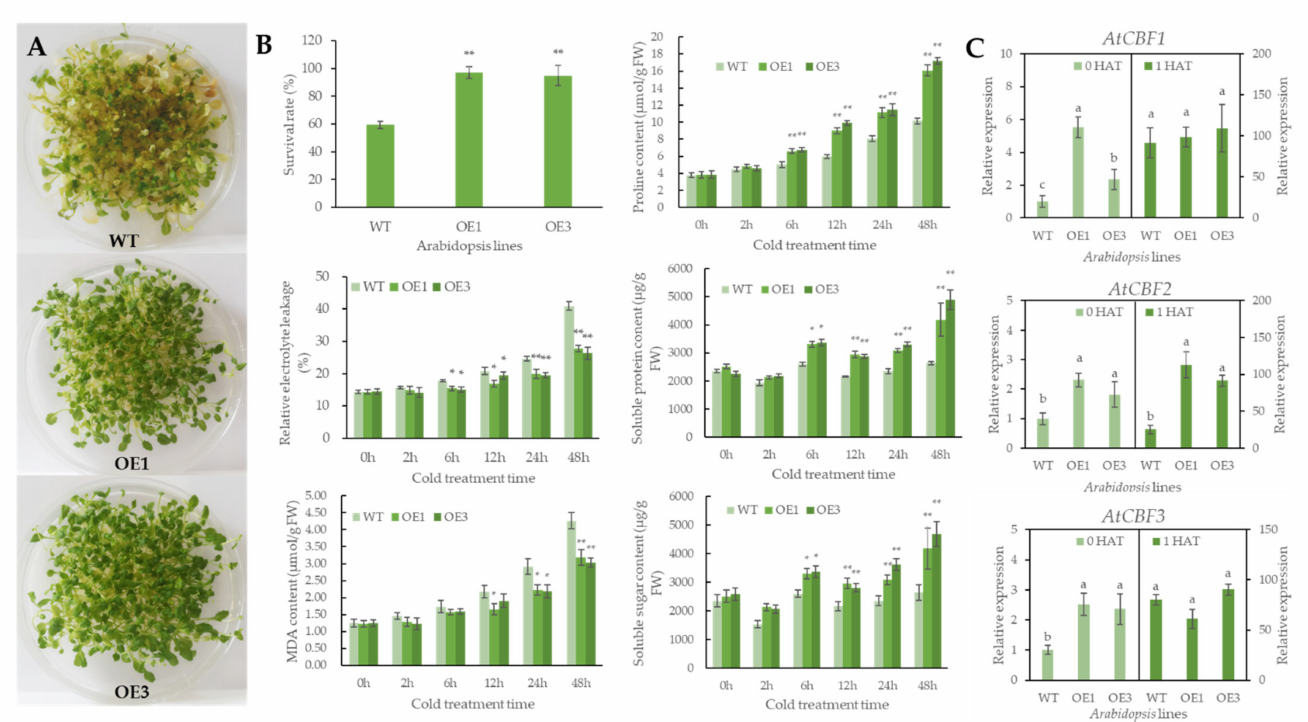
Figure 5. Comparison of growth, physiological indices and CBF gene expressions between wild-type (WT) and SgGH3.1 overexpressing (OE1 and 3) A. thaliana seedlings after cold treatment. ( A ) Growth of WT and SgGH3.1 -OE lines after 2-week recovery following cold treatment. ( B ) Survival rates and physiological variations of WT and SgGH3.1 -OE lines after cold treatment, * and ** indicate significant differences at p < 0.05 and p < 0.01 with 0 h, respectively. ( C ) Expression variations of AtCBF1, 2 and 3 genes in WT and SgGH3.1 -OE lines after 1 h cold treatment, the left Y axis represents the expression level prior to cold treatment (0 HAT), and the right Y axis represents the expression level 1 h after cold treatment (1 HAT), different letters above the columns indicate significant differences at p < 0.05 between different Arabidopsis lines within the same